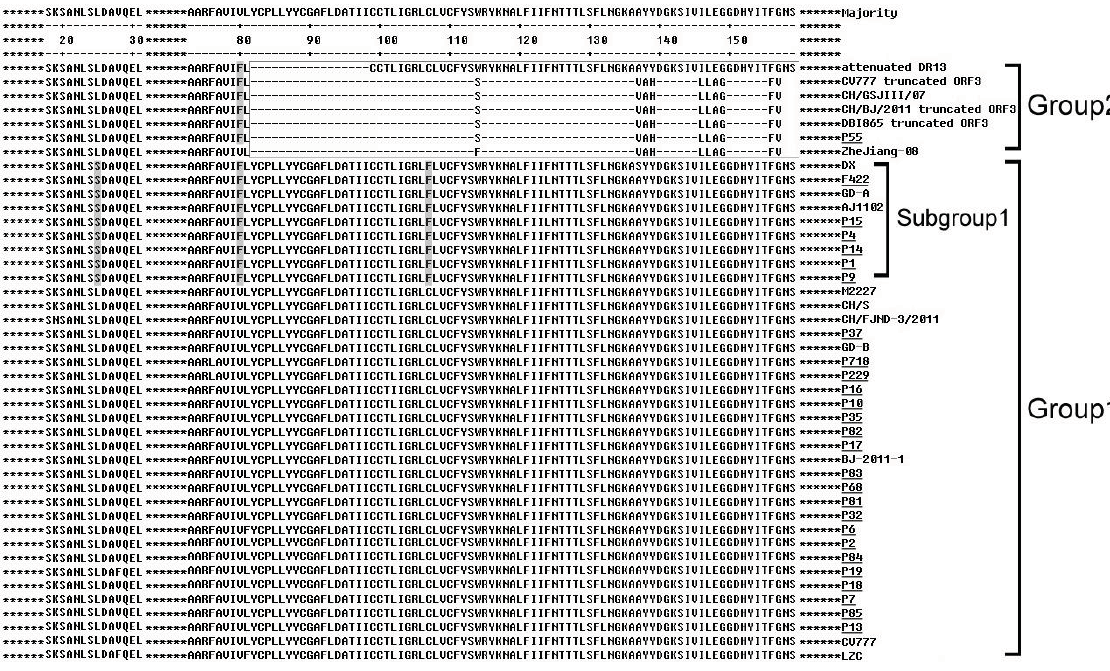
Figure 2. Alignment of amino acid sequences of ORF3 proteins of Fujian PEDV strains and reference strains. The asterisks represent the segments with no differences and not shown in this figure. The dashes represent deleted amino acids. The shadows indicate the unique substitutions of chosen strains. The boxes indicate the unique insertions or deletions of chosen strains. The underlines represent the Fujian field samples in this